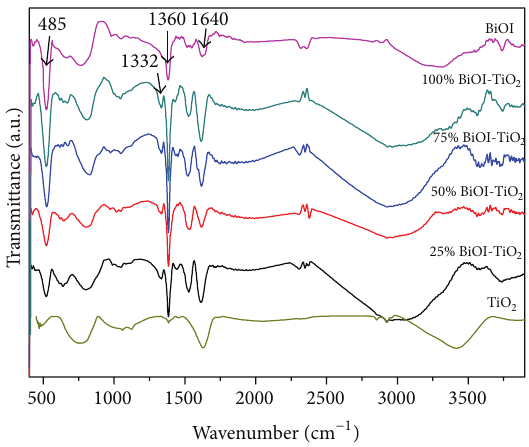
Figure 4: UV-Vis diffuse reflectance spectra of TiO 2 , BiOI, and BiOI-TiO 2 nanoparticles.